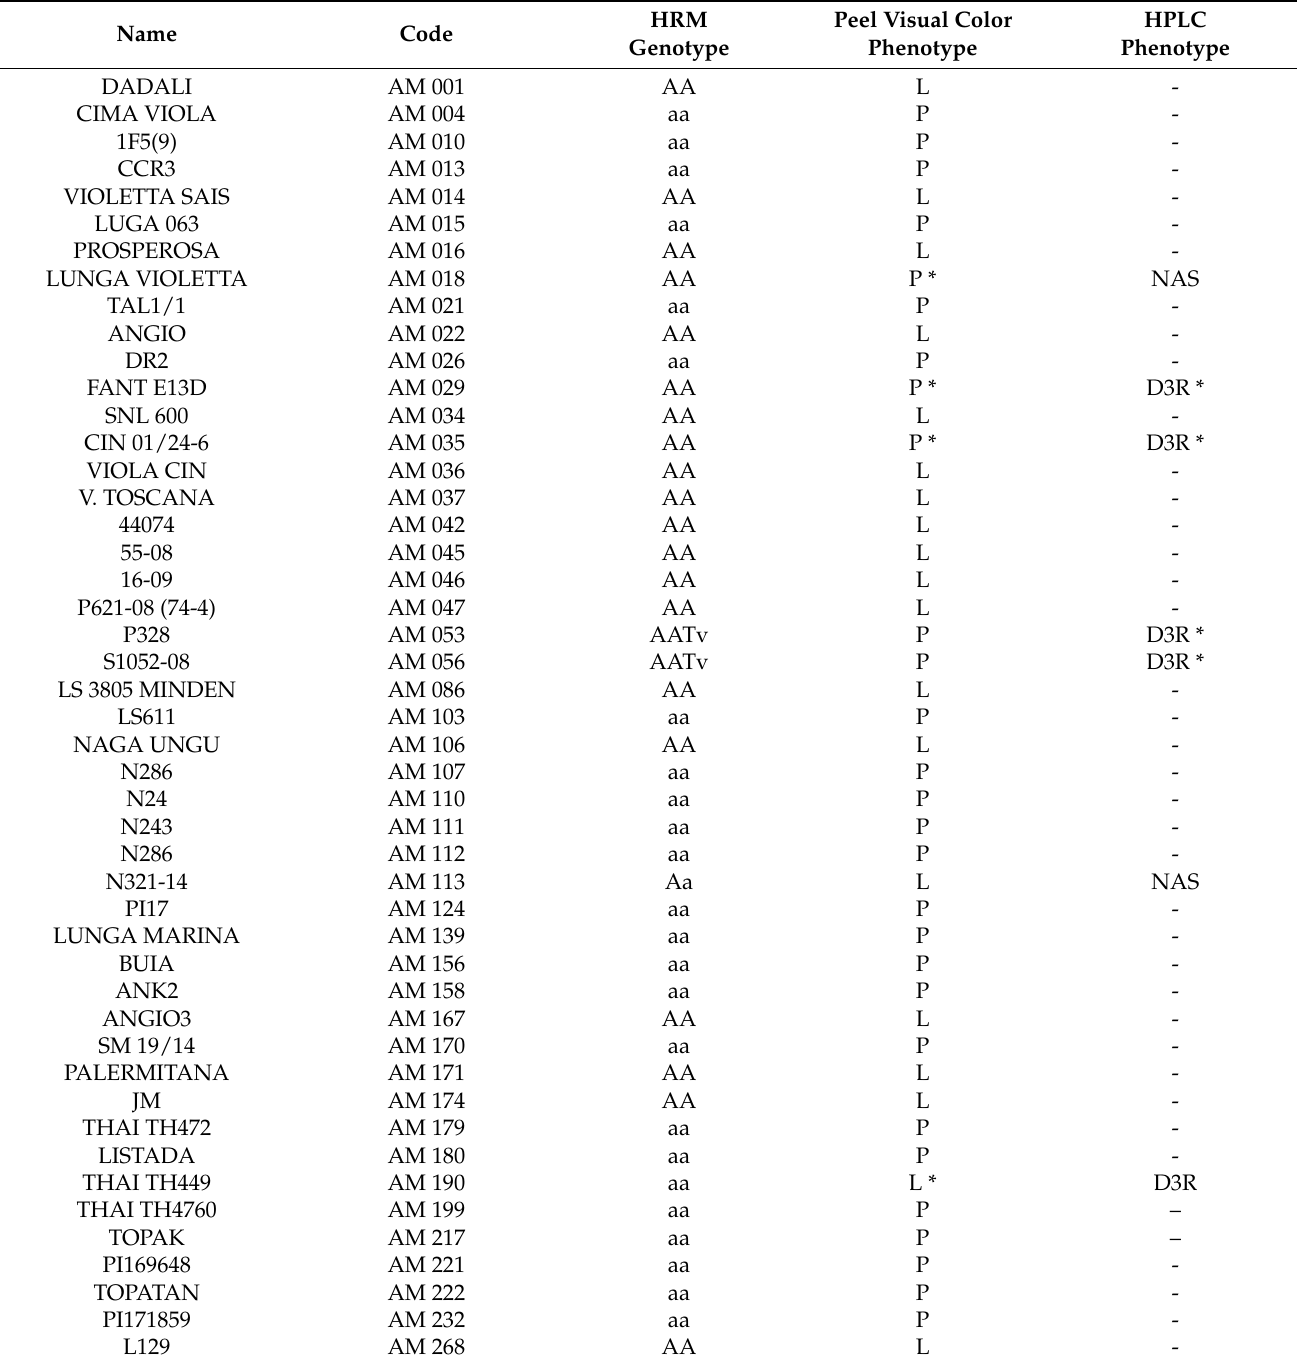
Table 2. Validation of the HRM_AAT marker in different anthocyanin colored CREA